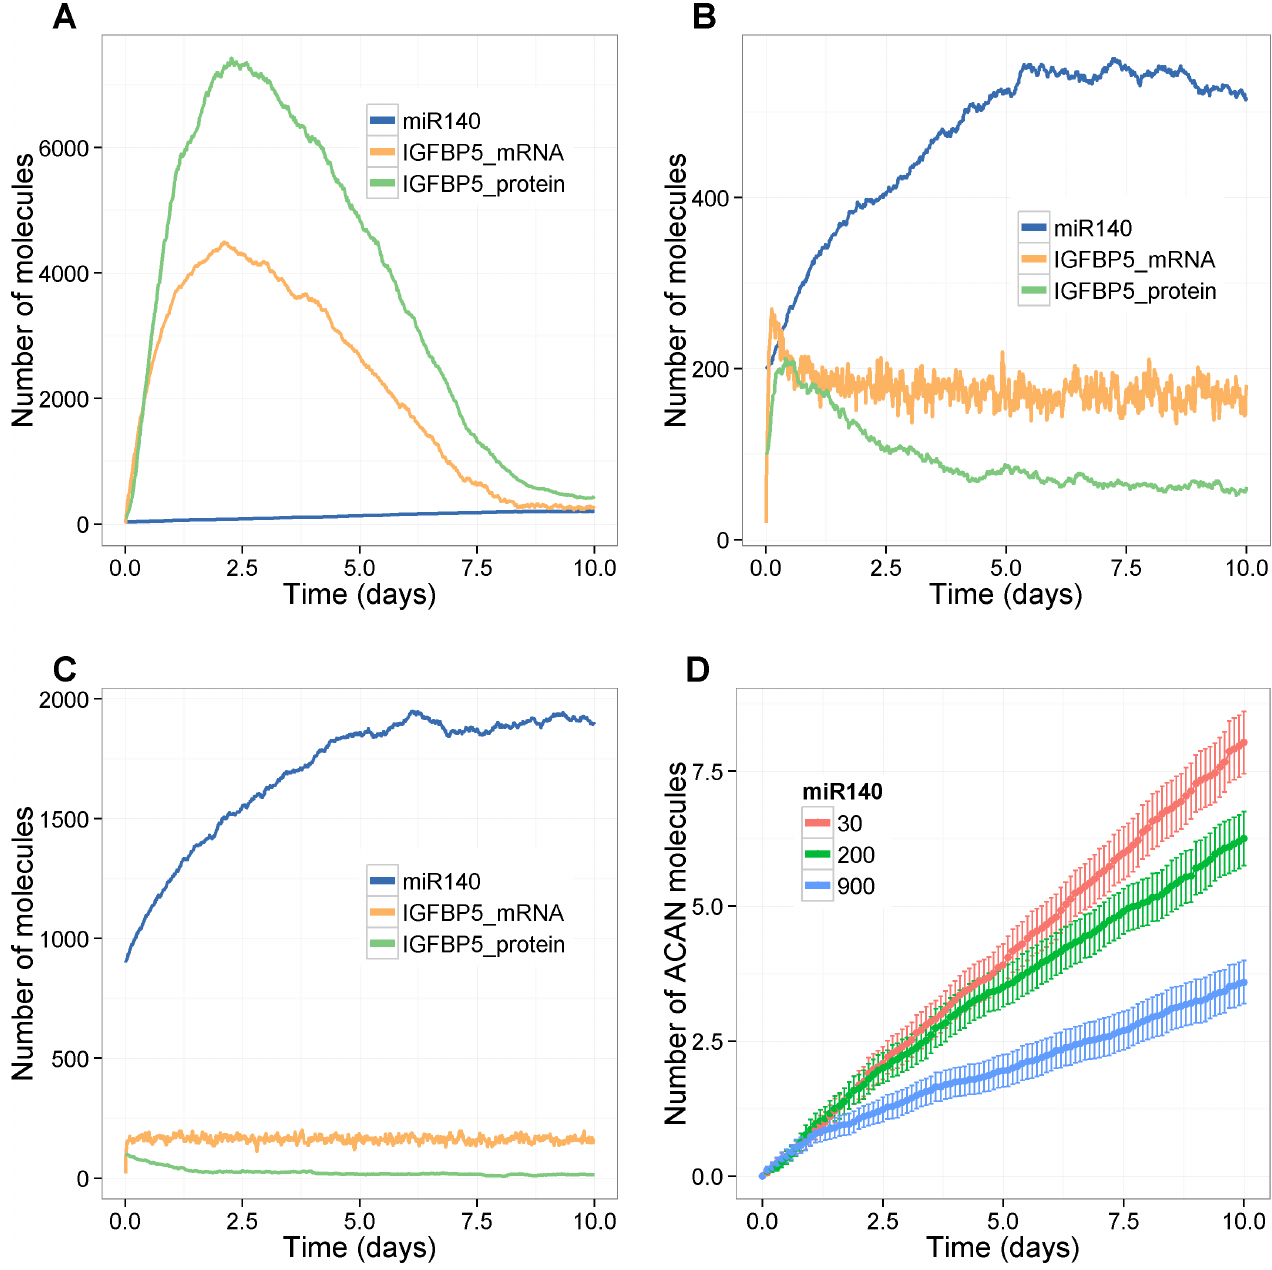
Fig 7. Effect of chronic activation of TNF- α on miR-140, Igfbp5 and Acan. A - F , Tnfa = 500 initially, k degTnfa = 1e-5 A , Low levels of miR-140 (miR140= 30 initially, k synmiR140 = 6e-5 s -1 , k synmiR140NFkB = 1.5e-4 s -1 ); B , Basal levels of miR-14-0(mir140 = 200 initially, k synmiR140 = 4e-4 s -1 , k synmiR140NFkB = 1e-3 s -1 ; C , High levels of miR-140 (miR140= 900 initially, k synmiR140 = 1.8e-3 s -1 , k synmiR140NFkB = 4.5e-3 s -1 ); D , Effect of miR-140 on ACAN levels (mean of 100 stochastic simulations; error bars indicateconfidenceinterval of the mean).